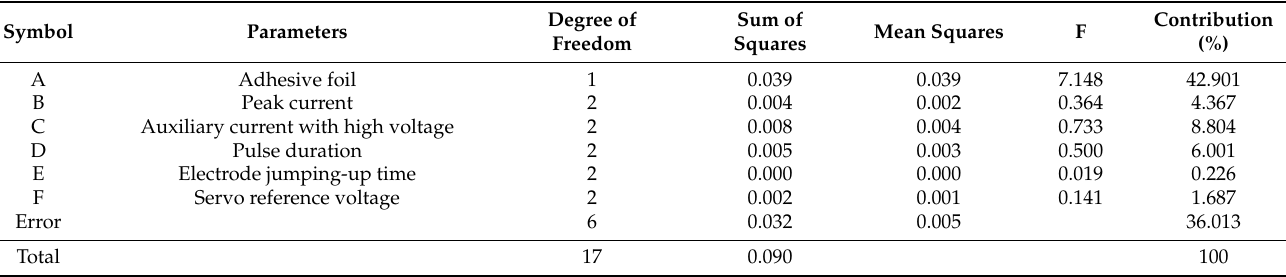
Table 14. Results of the analysis of variance.